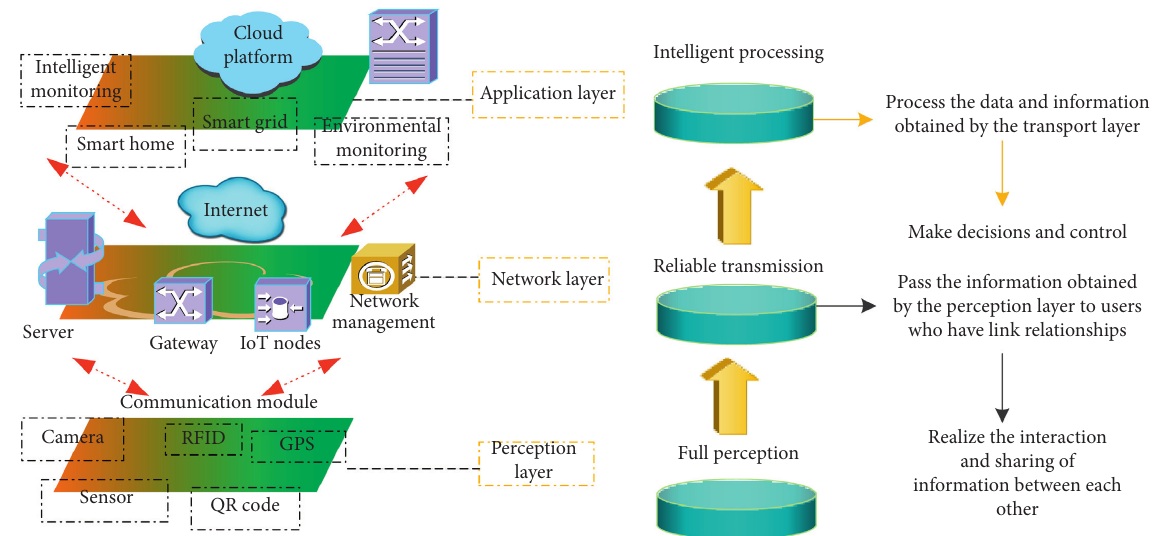
Figure 1: Architecture diagram of the Internet of